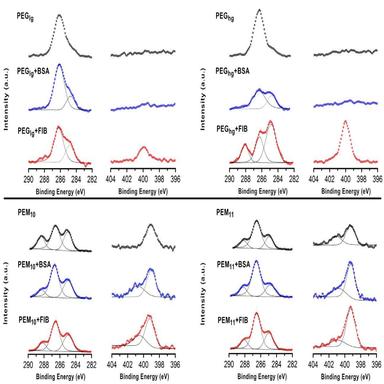
High-resolution XPS spectra of C1s and N1s envelopes of PEG (top) and PEM (bottom) surfaces before and after protein adsorption.